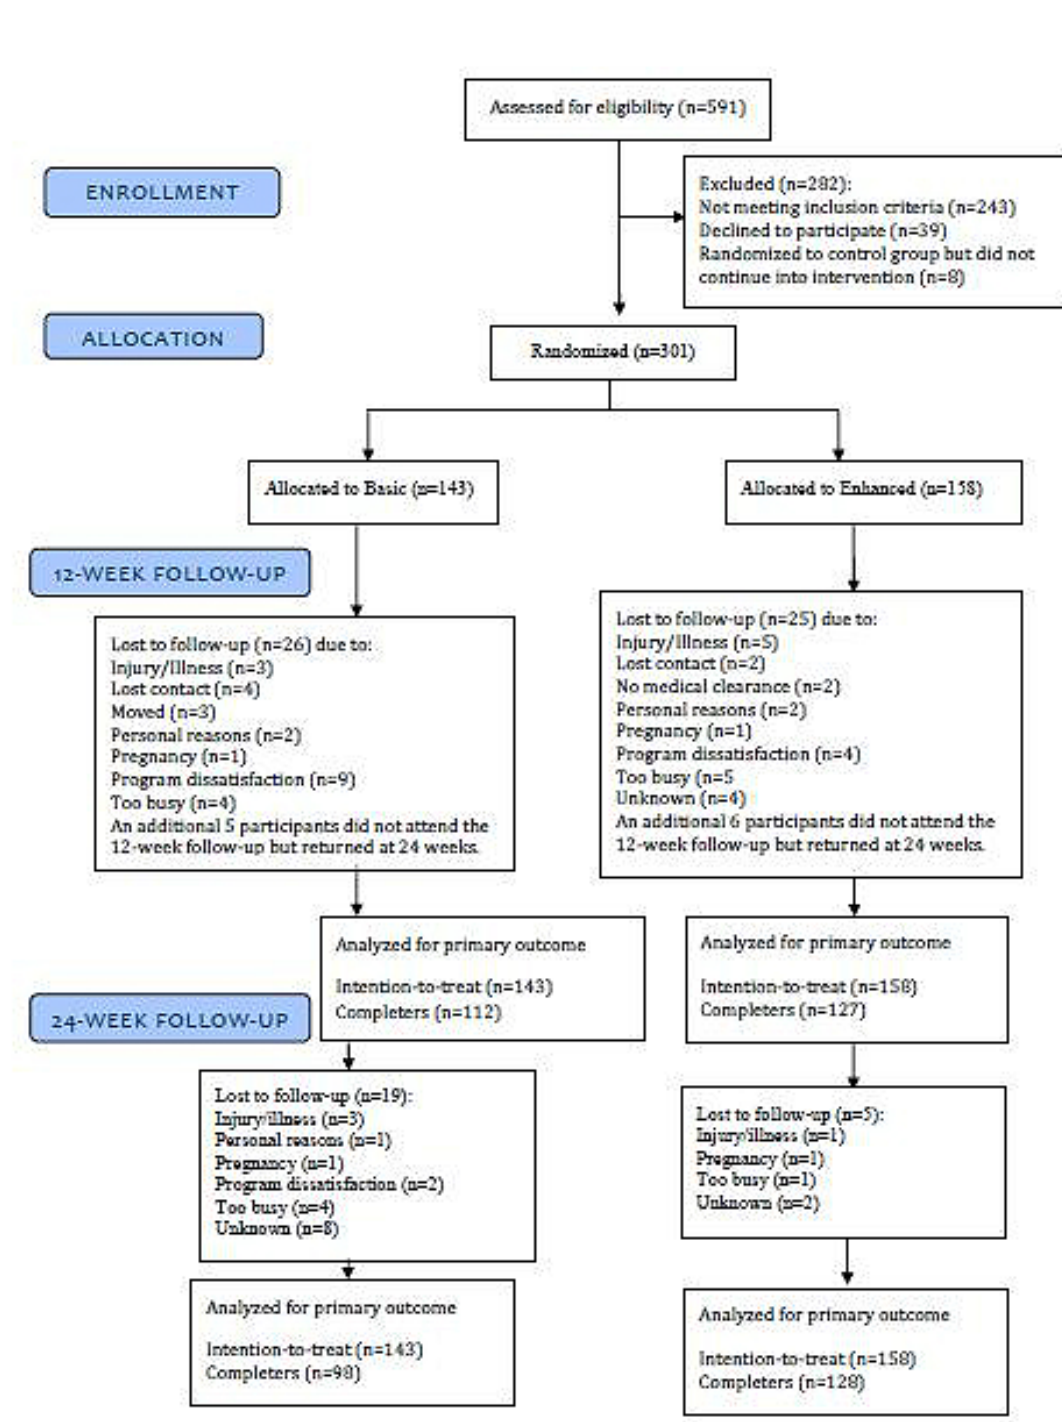
Figure 1. Participant